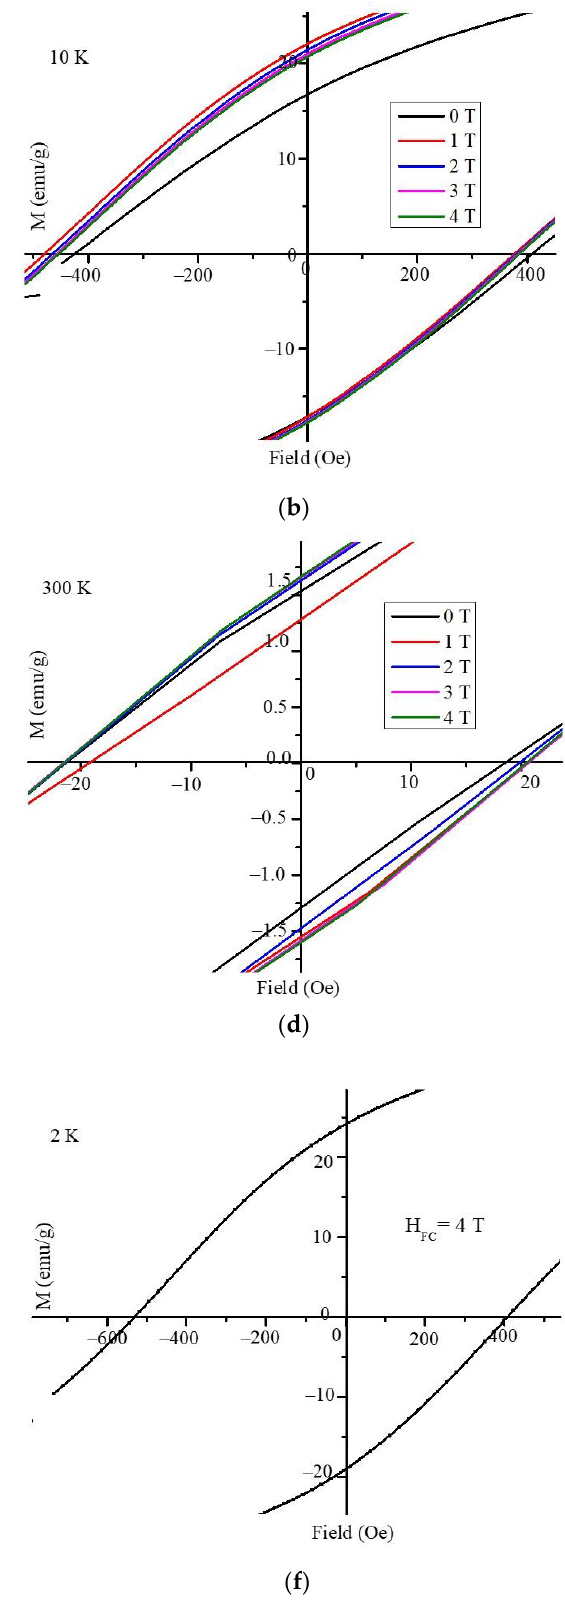
Figure 4. Enlarged portion of the MH loops at temperatures of ( a ) 2, ( b ) 10, ( c ) 100, and ( d ) 300 K. Shift in the MH loop at 2 K under FC of ( e ) 1 T and ( f ) 4 T applied magnetic field. Figure 5 displays the coercivity as a function of temperature at a zero applied field (0 T) and several field cooling values (1, 2, 3, 4 T). It can be seen that all curves have similar trends indicating the absence of any effect for the cooling field on the coercivity. At all cooled fields, H c has the highest value of 477 Oe at temperature 2 K with field cooling 1 T, and it decreases sharply with increasing temperature up to 100 K. Above 100 K, the coer- civity of the nanoparticles becomes negligible at all field cooling values. The inset is the comparison of the coercivity with respect to temperature of the undoped maghemite na- noparticles reported in our earlier study [26]. Figure 5. Temperature-dependent coercivity of the maghemite nanoparticles under field cooling of 0, 1, 2, 3, and 4 T (The inset is the coercivity as a function of temperature for undoped maghemite nanoparticles).